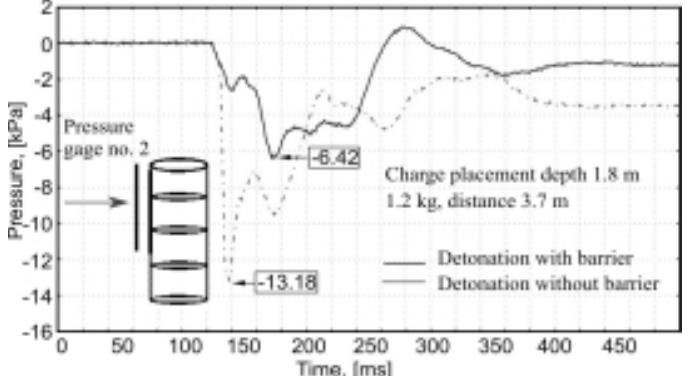
Fig. 17. Time histories of pressures p h on the structure front, measured by gage No. 2, from a detonation at 3.7 m from the silo.